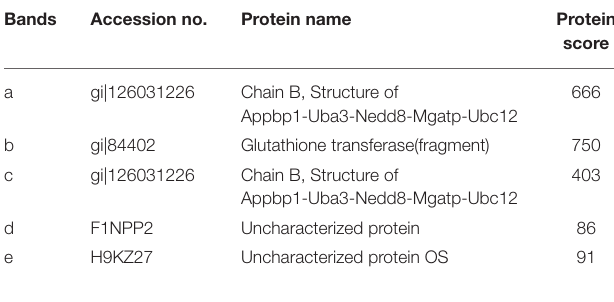
Figure S1. Internalization of rMGA_0676 by DF-1 cells increased with nuclease concentrations (Figure S1A). Internalization rates were also determined by incubating DF-1 cells with rMGA_0676 incubation times (Figure